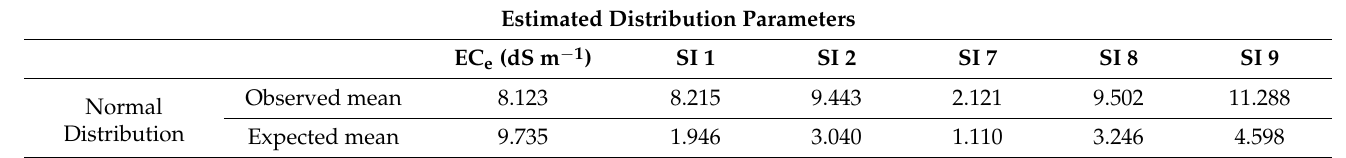
Table 7. Total estimated distribution parameters between observed means and expected means for EC e and soil salinity